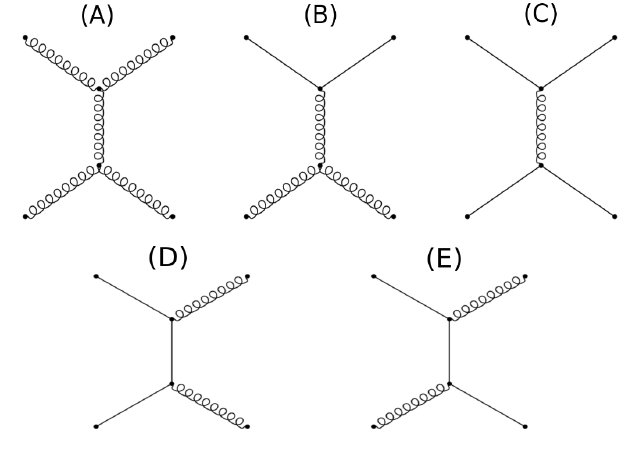
Figure 2 . Leading log diagrams for the scattering processes in a gauge theory with fermions. Solid lines as fermions and the helices represent gluons. Time may be regarded as running